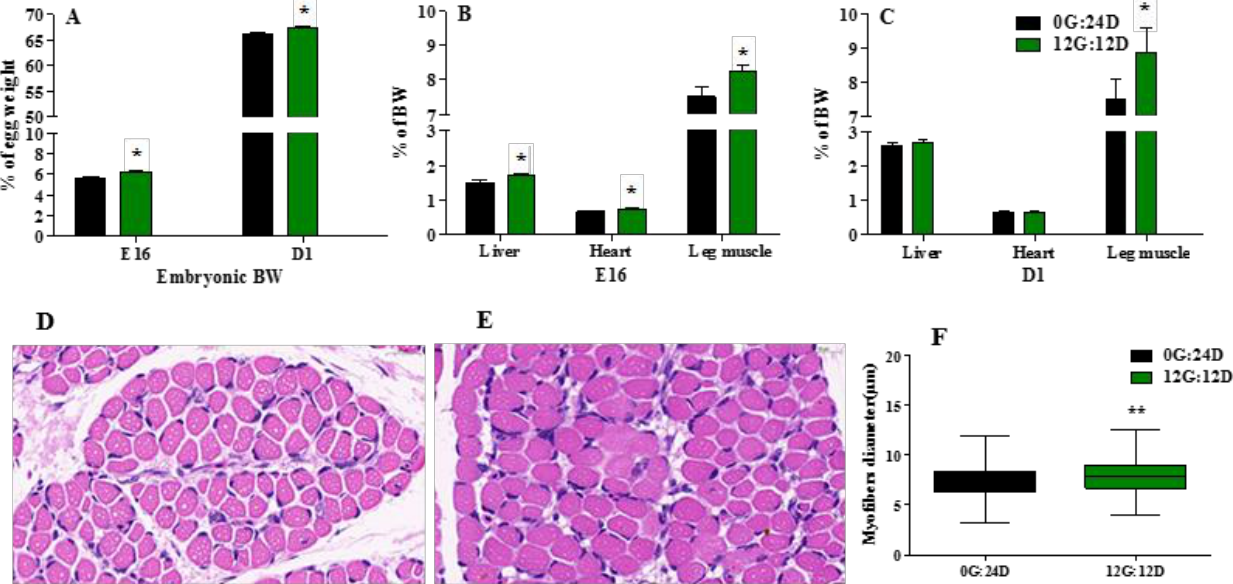
Figure 2. Effect of green light during incubation on embryo and organs development. ( A ) Embryonic BW, as percentage of embryo weight and egg weight incubated under green light or kept in the dark on E16 and D1. ( B ) Liver, heart and leg muscle weight as percentage of BW of on E16. ( C ) Liver, heart and leg muscle weight as percentage of BW of embryos on D1. ( D , E ) Image of higher magnifications (magnified 60 times) of representative areas from the gastrocnemius muscle (left) under dark and green light. ( F ) The myofiber diameter of gastrocnemius muscle. The data are presented as mean ± SEM. * p < 0.05, ** p < 0.01. Abbreviations: dark group, 0G:24D; green light group, 12G:12D; E16, embryonic days 16. D1, day of hatching; BW, body weight.